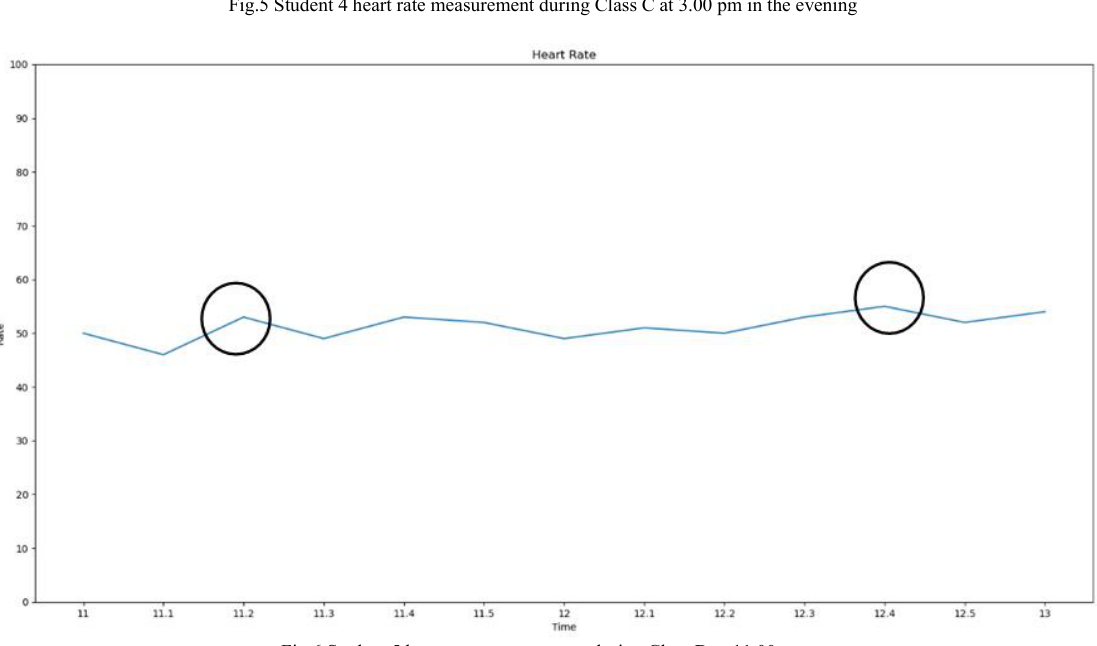
Fig.5 Student 4 heart rate measurement during Class C at 3.00 pm in the evening